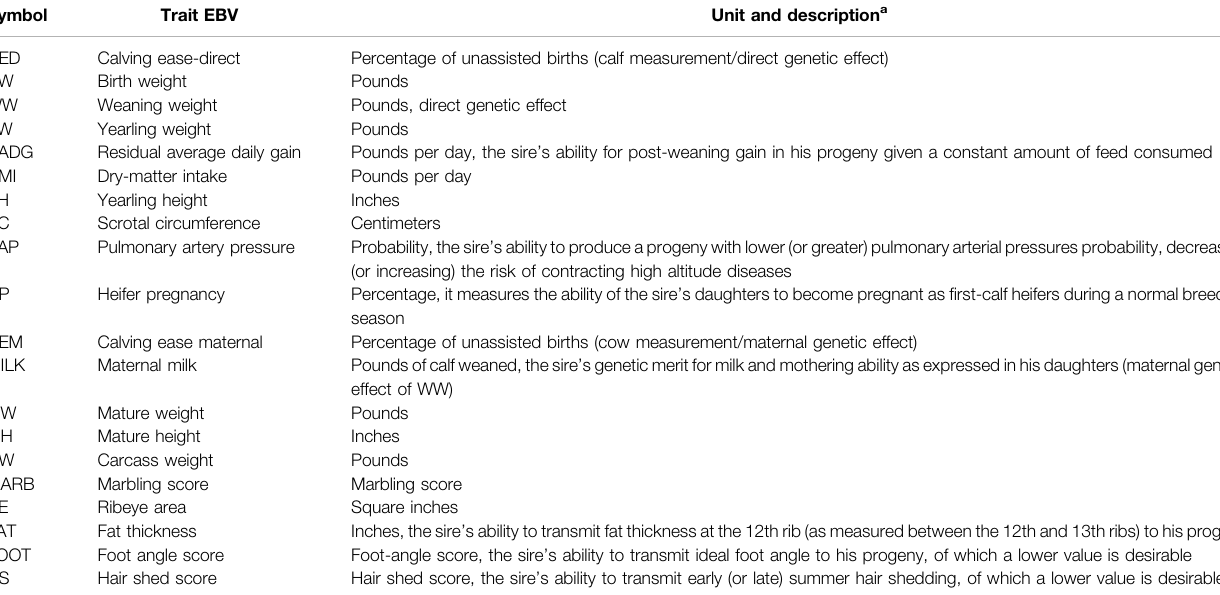
TABLE 3 | Description of production traits evaluated to be genetically correlated with yearling temperament score, as de fi ned by the American Angus Association. Symbol Trait EBV Unit and description